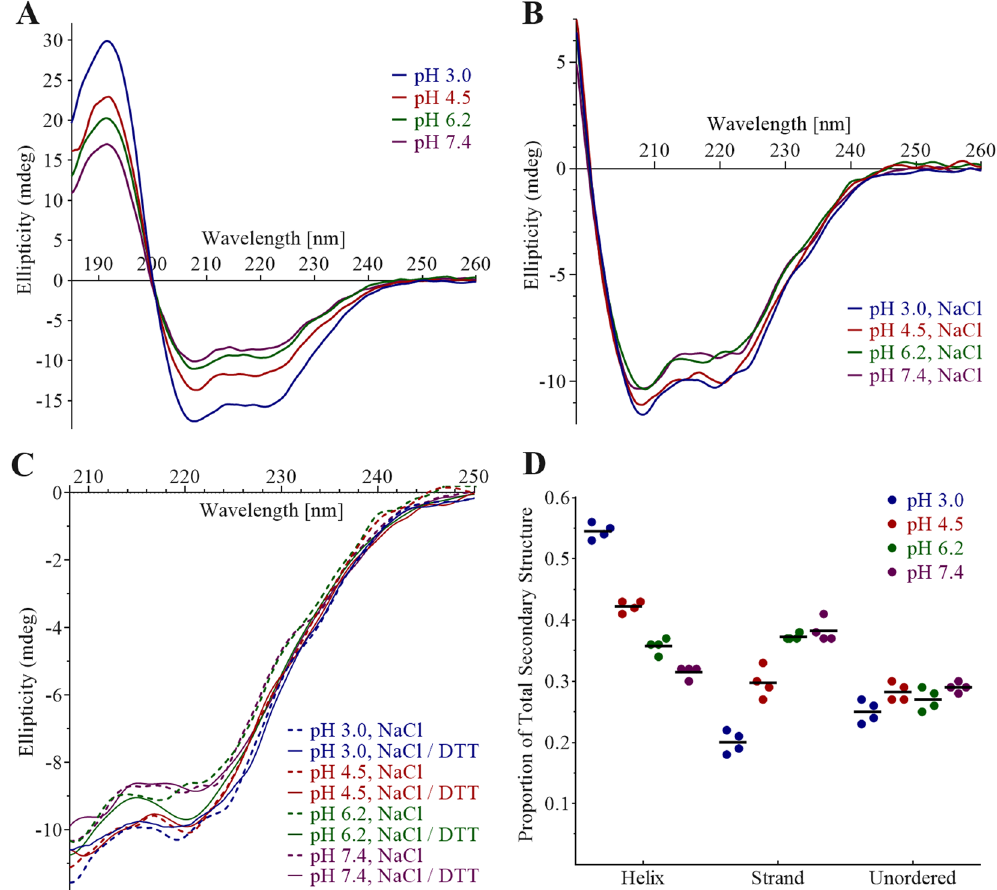
Figure 4. pH-dependence of PSI secondary structure. Far-UV CD spectra of 100 µ g/mL (8.5 µ M) StAP PSI were measured at pH 3.0 (blue), 4.5 (red), 6.2 (green), and 7.4 (purple) collected in ( A ) buffer; ( B ) buffer containing 140 mM NaCl; and ( C ) buffer containing 140 mM NaCl and 10 mM DTT, overlaid with spectra from ( B ). The respective buffers used were 27 mM sodium phosphate pH 3.0, 50 mM sodium acetate pH 4.5, 20 mM sodium phosphate pH 6.2, and 10 mM sodium phosphate pH 7.4. Secondary structure contents calculated for PSI in buffer are summarised in ( D